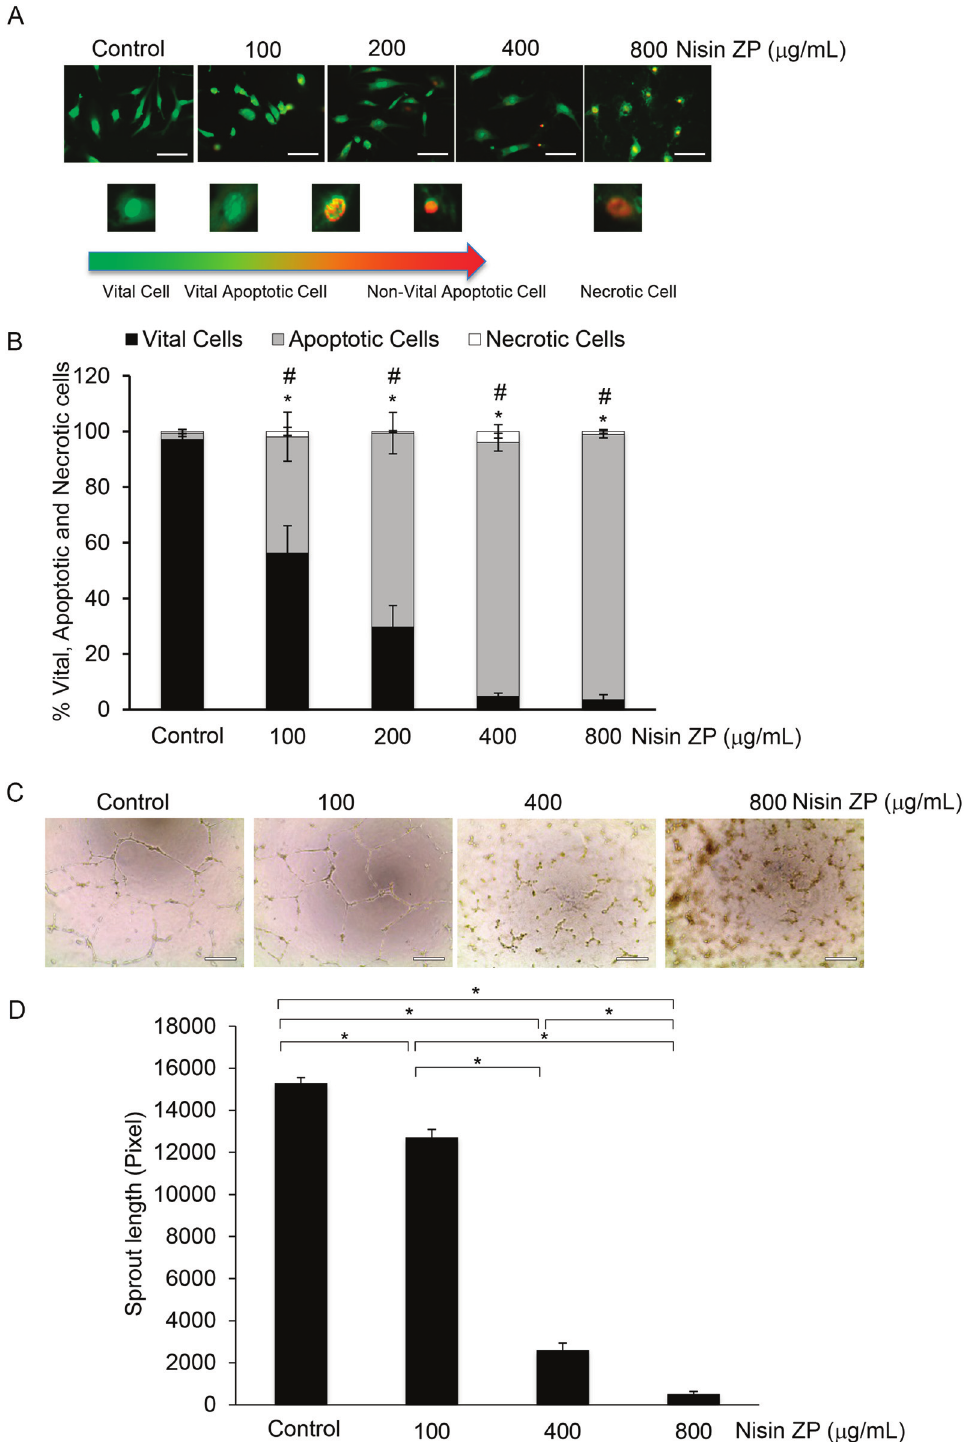
Fig 5. Nisin ZP induces endothelial cell apoptosis and inhibits angiogenic sprouting dose-dependently. A , Morphological observation of HUVEC cells treated with control media or media containing nisin ZP (100 to 800 μ g/mL) for 24h. Cells were then stained with an ethidium bromide and acridine orange (EB/AO) stain, imaged, and counted (Scale bars, 100 μ m). B , Graph showing percentage changes in vital, apoptotic, and necrotic HUVEC cells treated with control media or media containing nisin ZP (100 to 800 μ g/mL) for 24 h. Comparisons between groups relative to controls were analyzed by ANOVA with the level of significance set at * p < 0.05 vital cells; # p < 0.05 apoptotic cells. C , Microscopic images of sprouting assays for cells (HUVEC) treated with control